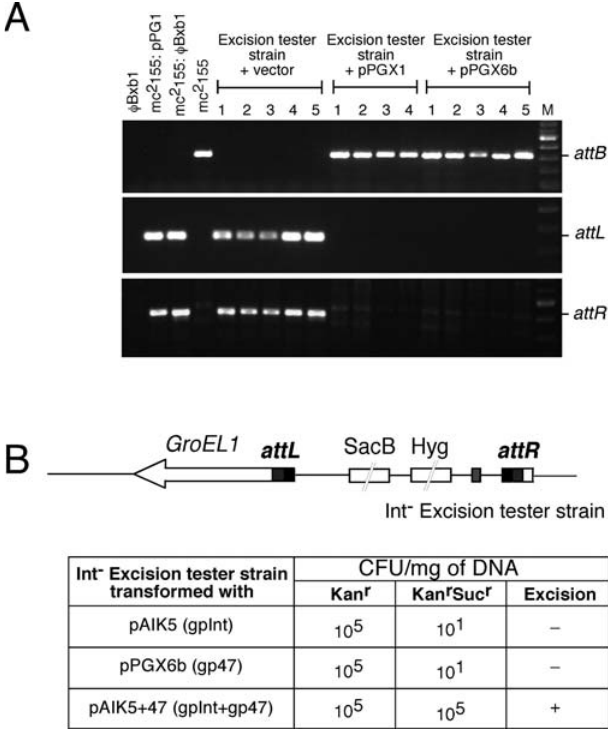
Figure 2. Confirmation of Site-Specific Recombination and Bxb1 Integrase Dependence (A) DNA from five sucrose-resistant transformants of the excision tester strain transformed with either pPG1 (empty vector), pPGX1, or pPGX6b was examined by PCR for the presence of attB, attL, and attR . Transformation with pPGX1 and pPGX6b leads to the presence of a product amplified with attB -specific primers; no product is observed using primers that amplify attL and attR. DNA from a Bxb1 lysogen and from clones transformed with the empty vector that were used as controls show a product corresponding to attL and attR, whereas DNA from wild-type mc 2 155 shows the presence of a product corresponding to attB . (B) An int (cid:1) excision tester strain was created (as in Figure 1A) using transient expression of gpInt. The int (cid:1) tester strain was then transformed with pAIK5 (gpInt alone), pX6b (gp47 alone), or pAIK5 þ 47 (gpInt þ gp47), and the frequency of suc R colonies (and therefore excision) determined. CFU, colony-forming units DOI: